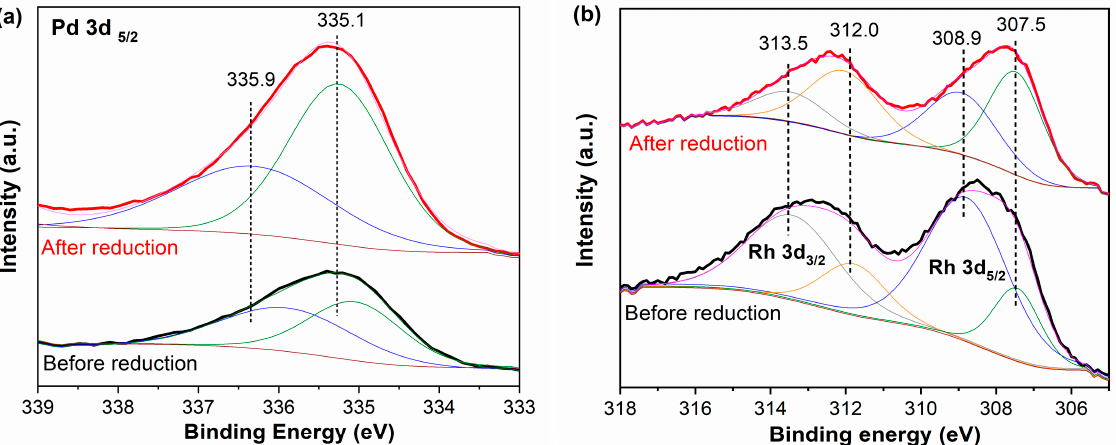
Figure 2. X-ray photoelectron spectroscopy spectra recorded over ( a ) Pd/C and ( b ) Rh/C catalysts before and after treatment with H 2 . The Pd 3d 5/2 , Rh 3d 3/2 and Rh 3d 5/2 regions.